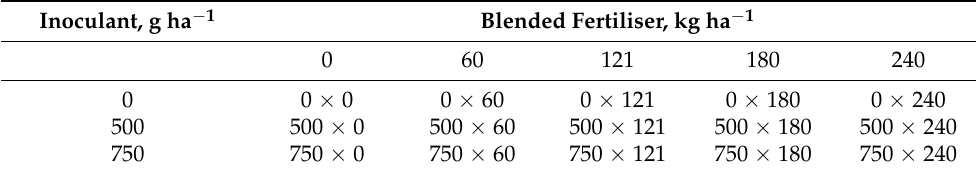
Table 1. Treatment combinations of the blended fertiliser and the inoculant for the experiment. Inoculant, g ha −